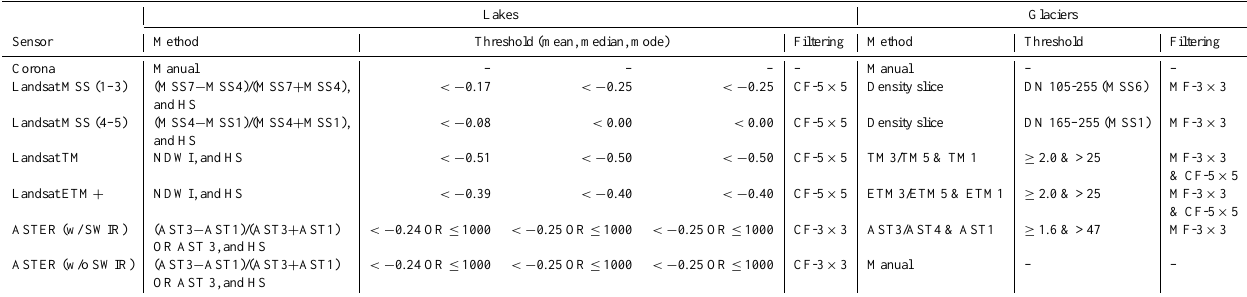
Fig. 5. ASTER image illustrating how lakes of both high- and low-sediment concentrations were classified in this study. (a) highlights part of the western QIC where lakes of differing sediment contents exist, (b) shows the results of the (AST3 − AST1)/(AST3 + AST1) ratio (blue pixels: < − 0 . 25), (c) shows ASTER B3 (red pixels: ≤ 1000), and (d) illustrates the final result when a combination of both methods are used. Note that none of these methods provide a perfect classification, and some lakes remain unidentified (the yellow star indicates the proglacial lake of Qori Kalis glacier and is unclassified using these methods). Yellow dashed line indicates the approximate line of separation between higher and lower sediment content lakes, which is roughly related to distance from the QIC. Table 2. Summary of methods and thresholds used in lake and glacier classifications. The threshold for shadows in the hillshades (HS) was DN <70 for all images. DN represents digital number; CF and MF with their kernel sizes stand for closing filter and median filter,